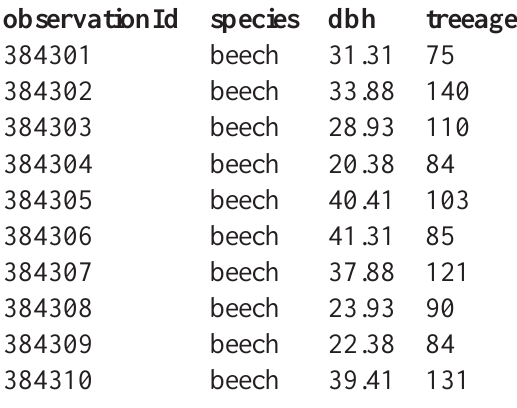
Table 1: Example data set: Measurement of dbh.